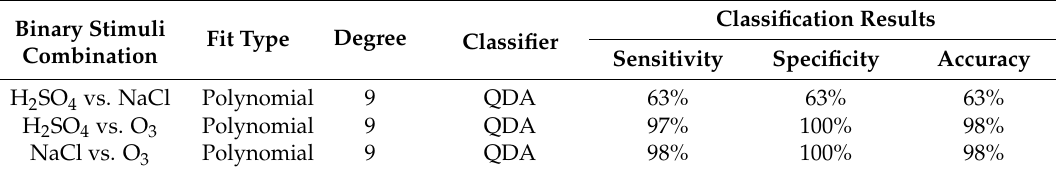
Table 5. Classification results using 5th Degree Polynomial and QDA